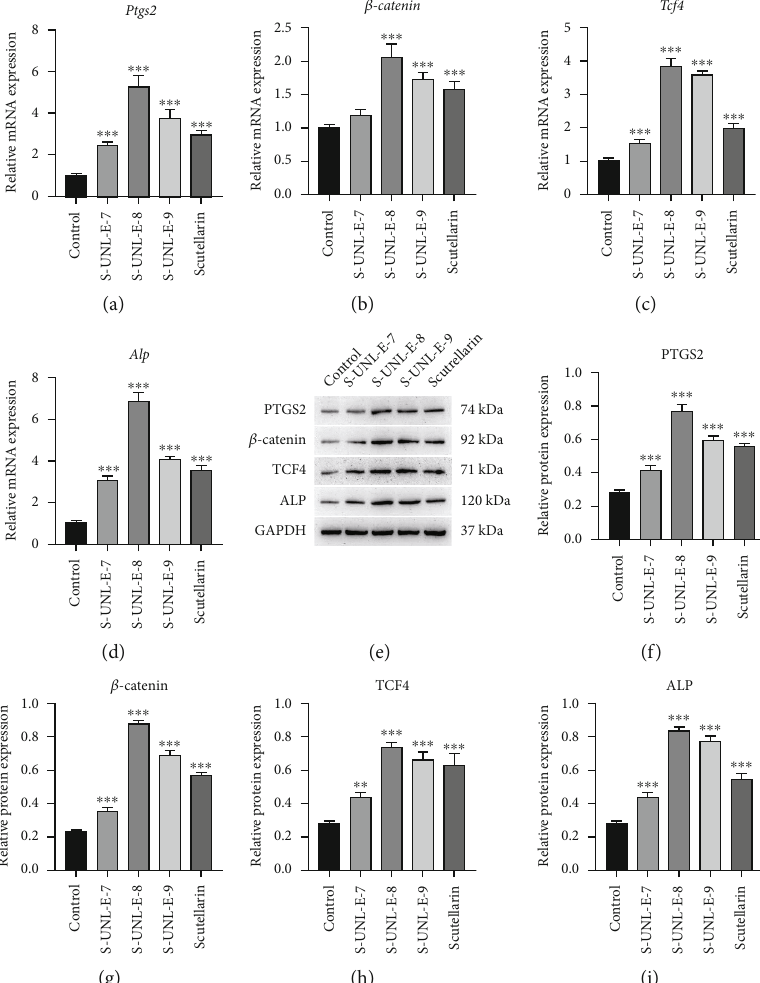
Figure 4: Relative mRNA and protein expressions of PTGS2, β -catenin, TCF4, and ALP after osteoblasts were treated with 2 × 10 7 , 2 × 10 8 , and 2 × 10 9 S-UNL-E. (a – d) The mRNA levels were analyzed by qRT-PCR. (e) The expression levels were analyzed by western blot. (f – i) The western blot results were quali fi ed. ∗∗∗ p < 0 : 001 vs.